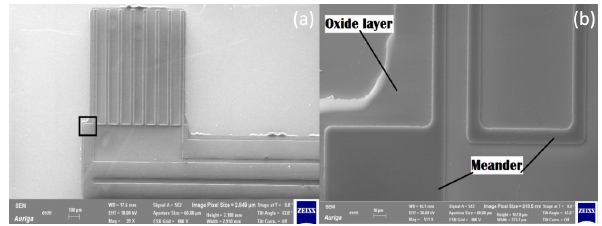
Figure 5. SEM micrographs of (a) one of the fabricated meanders isolated with aluminum oxide from the top; (b) zoomed-out view of the corner of the